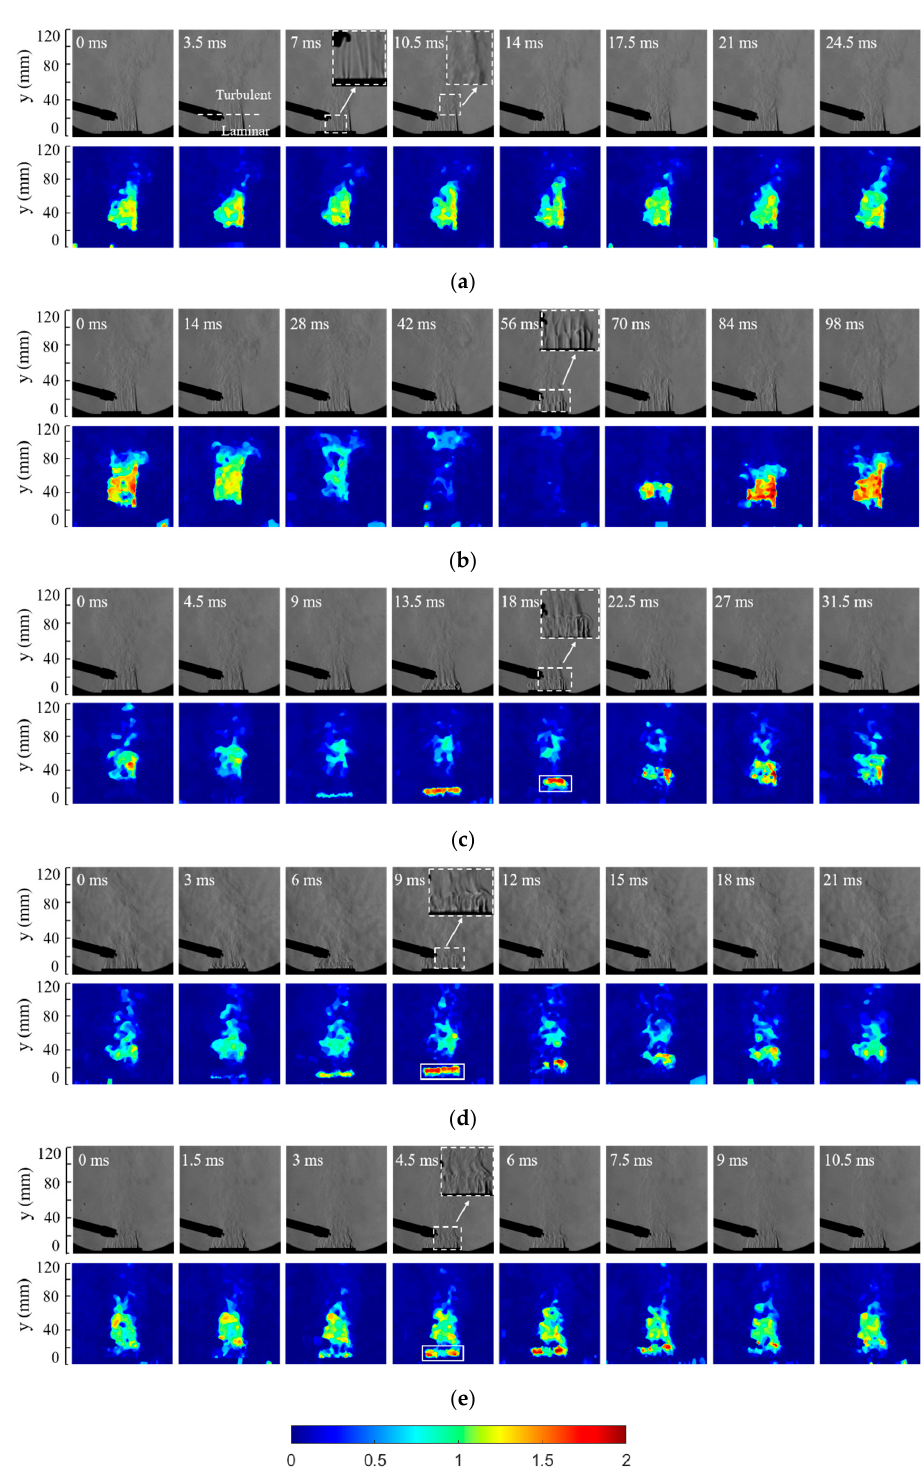
Figure 5. Schlieren and velocity contours of cold flow field under different conditions: ( a ) no acoustic excitation; ( b ) 10 Hz excitation; ( c ) 30 Hz excitation; ( d ) 50 Hz excitation; ( e ) 100 Hz excitation.